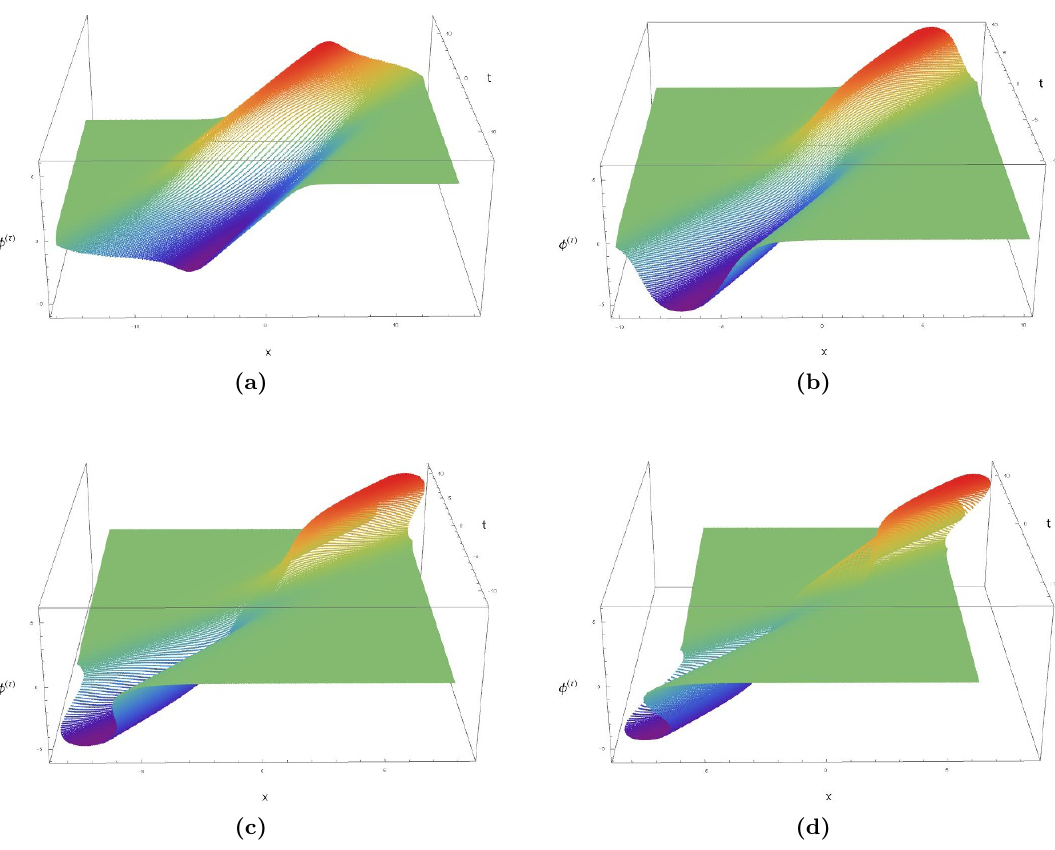
Figure 3. The T (cid:22) T -deformed two-kink solution ( m = (cid:12) = 1 ; a 1 = 2 ; a 2 = 3), for di(cid:11)erent values of the perturbation parameter (cid:28) . Figure 3b represents the undeformed solution. Figure 3a